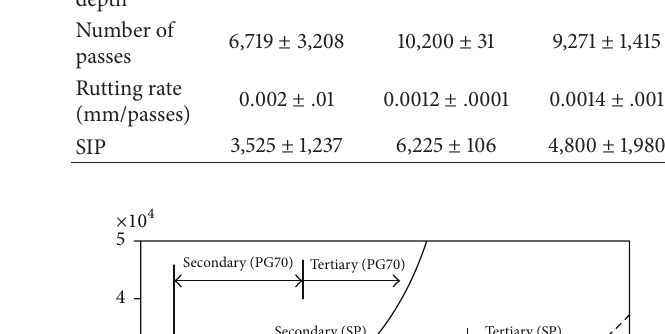
Figure 5: The rutting evolution for SP mixture using HWTT.